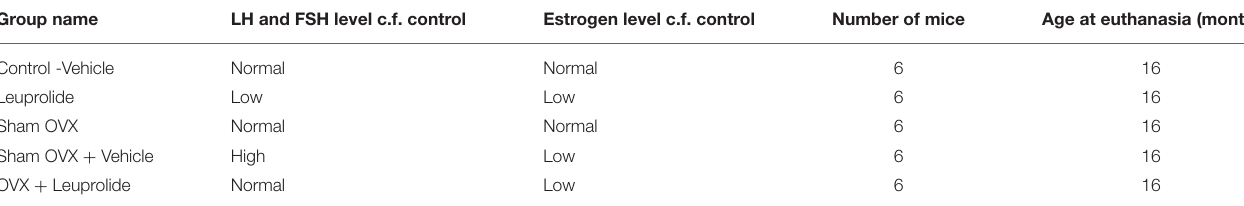
TABLE 1 | Summary of treatment groups for hormonal modulation of sex steroids and